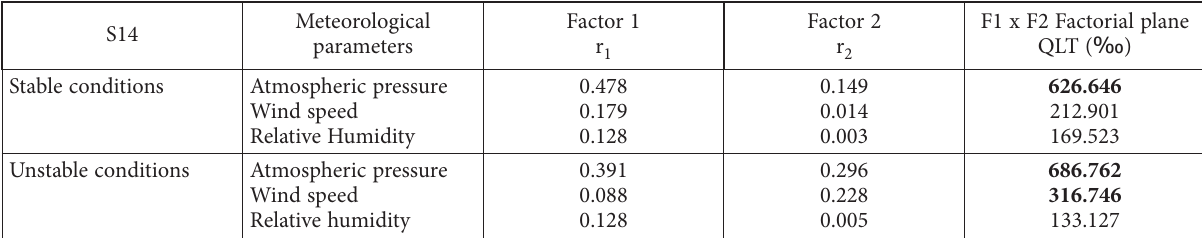
Table 5. Representation qualities (QLT) of selected meteorological parameters as a function of the two first axes of the (1x2) factoriel plane (‰) (Case of S14 site- the threshold of significance = 250 for p < 0.05 and n = 22)